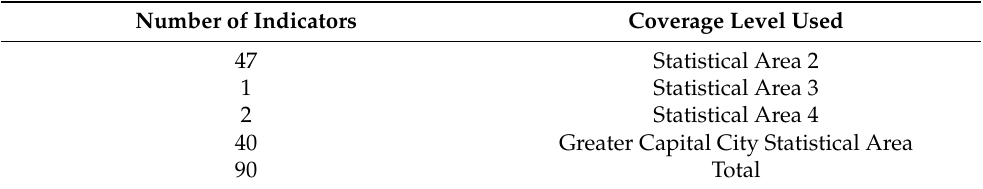
Table 3. Number of indicators from different coverage